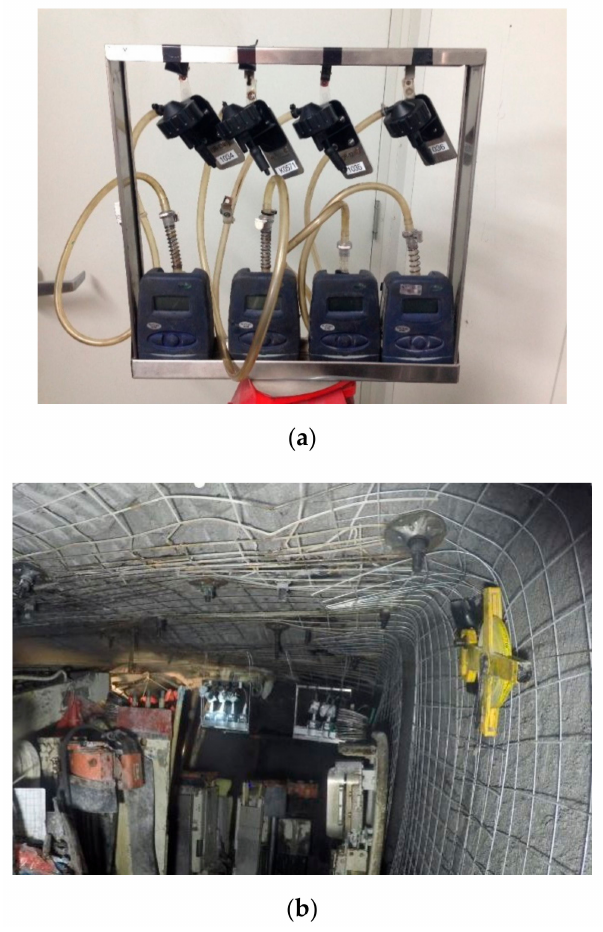
Figure 1. ( a ) Photo of sampling trains set up inside the frame. ( b ) Photo of sampling frames installed on continuous miner during